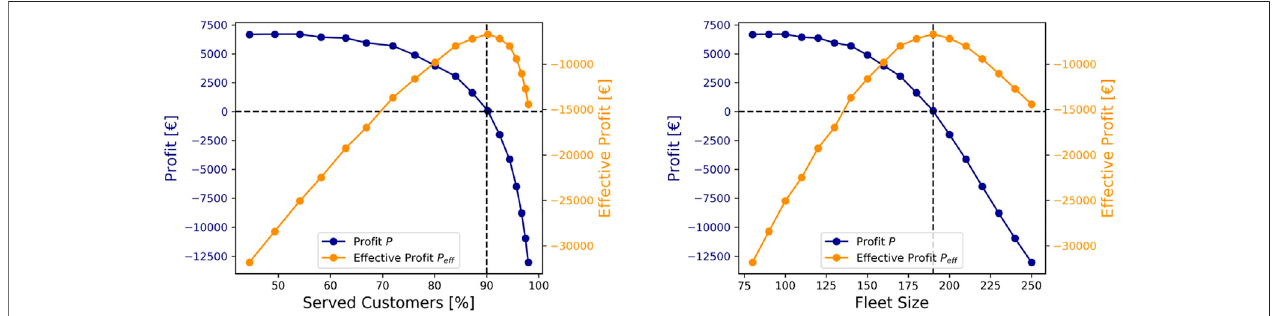
FIGURE 6 | Calibration of break even fare and unserved customer penalty. The break even fare ischosen to achieve 0 € Pro fi t at 90% served customers, while the unserved customer penalty is set to result in a maximum for the Effective Pro fi t at 90% served customers as shown in the left fi gure. 190 vehicles are needed for each operator to served 90% customers as depicted in the right fi